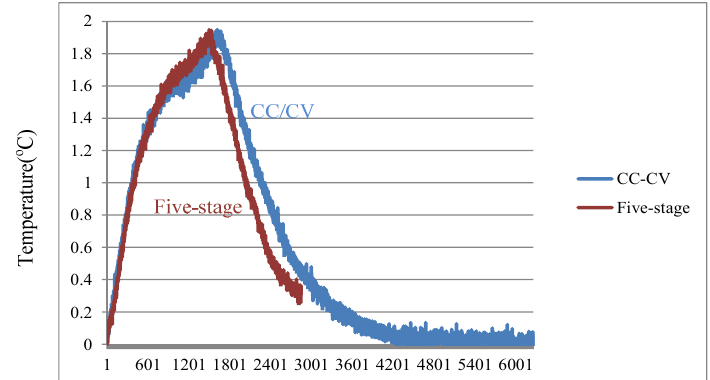
Figure 9. Temperature rise of the five-stage CC charging algorithm and the conventional CC-CV